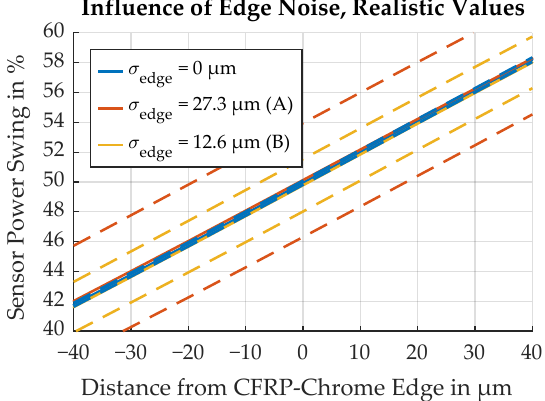
Figure 19. Simulation results of the influence on threshold position for variation of σ edge for realistic values from Variants A and B. Dotted lines represent ± σ .